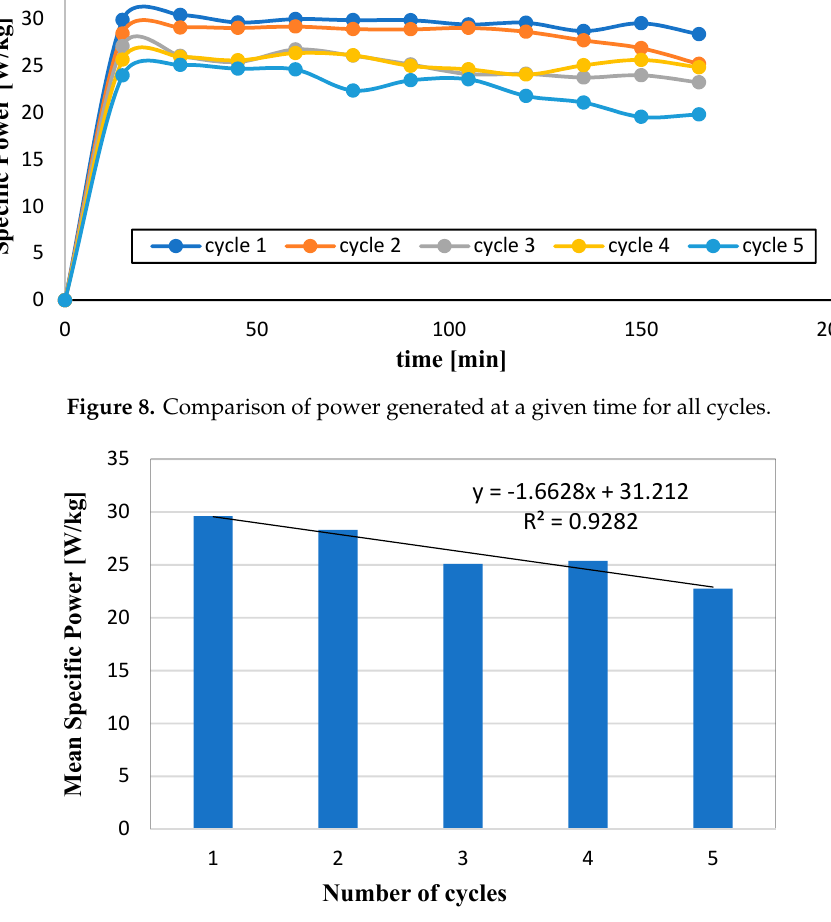
Figure 8. Comparison of power generated at a given time for all cycles.